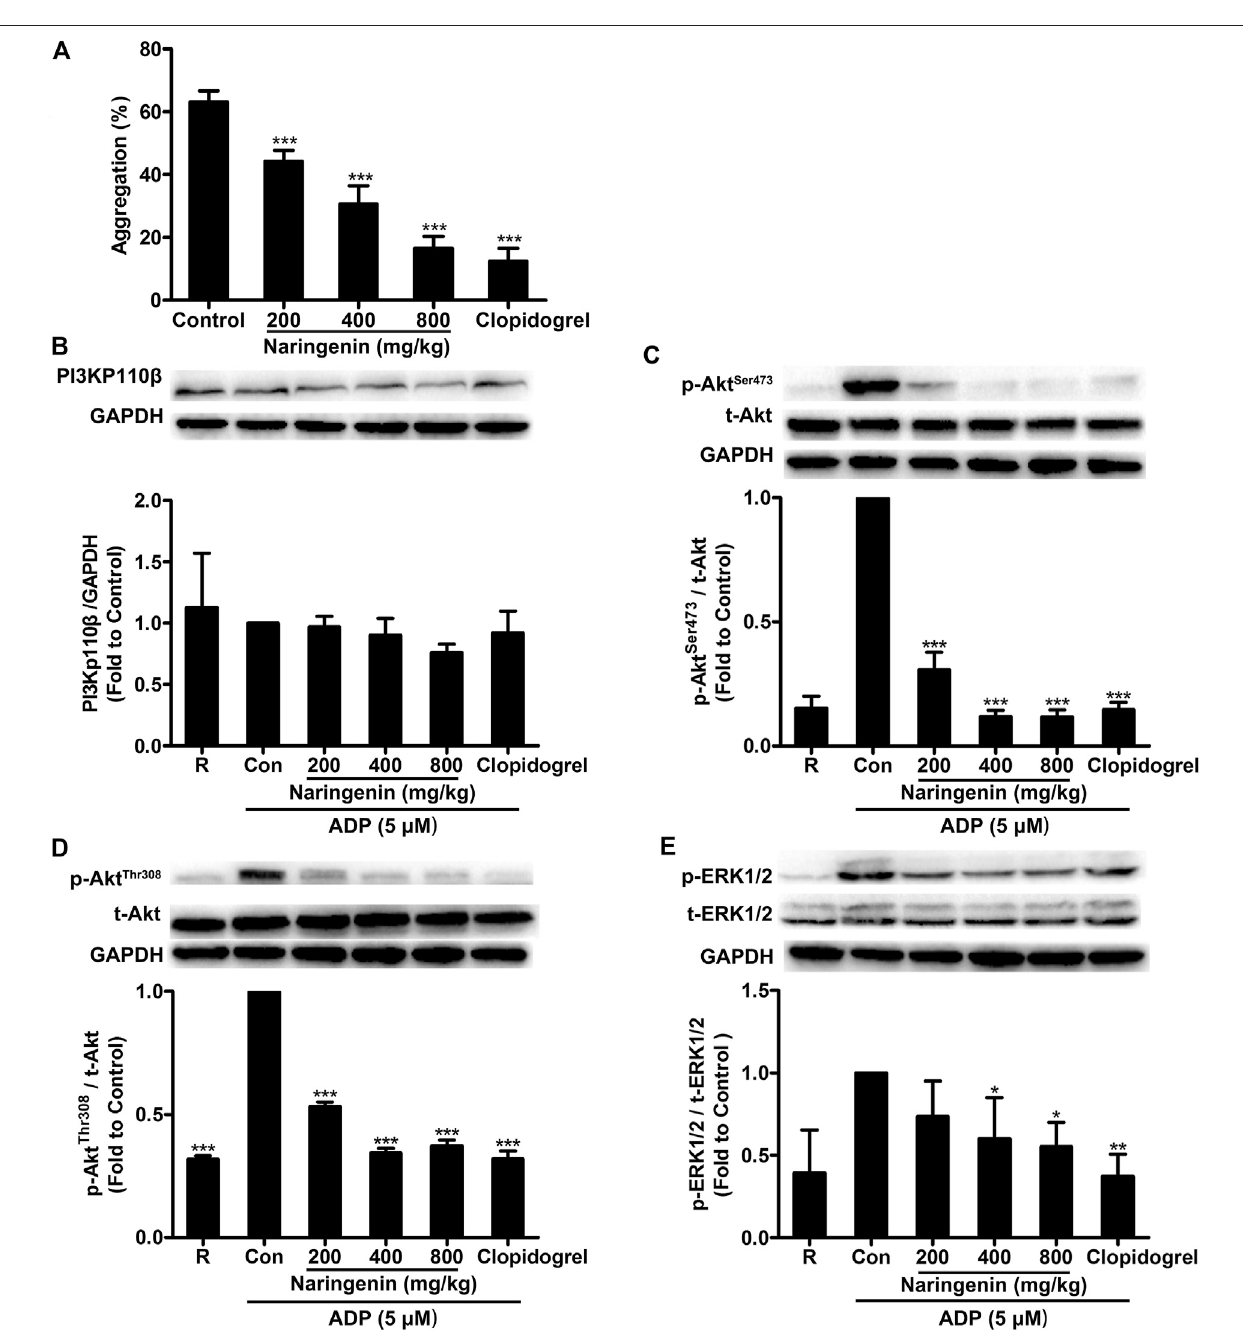
FIGURE 8 | Intragastric administration of naringenin inhibits ADP-induced rat platelet aggregation and platelet PI3K signaling phosphorylation. Rats were orally administered naringenin (200, 400, and 800 mg/kg), clopidogrel (7.875 mg/kg) or vehicle (0.5% CMC-Na) for 7 days. Blood was collected and PRP was obtained after thelasttreatment.PlateletaggregationwasinducedbyADP(5 μ mol/L) (A) .Dataareexpressedasmeans ± SD( n (cid:2) 6).AfterADPstimulation,plateletproteinswerethen extracted and analyzed by immunoblotting using PI3Kp110 β antibody (B) and phospho-speci fi c antibodies such as Akt Ser473 (C) , Akt Thr308 (D) and ERK1/ 2 Thr202/Tyr204 (E) . Total level of GAPDH was measured on each sample as a loading control. The blots shown are representative of three separate experiments. The relative protein expression levels were quanti fi ed by ImageJ 1.47v software. The level of relative protein expression obtained with vehicle control was taken as 1. R represents the level of relative protein expression in resting platelets. Data are expressed as means ± SD ( n (cid:2) 3). * p < 0.05, ** p < 0.01, *** p < 0.001 compared with the vehicle control group (Con).